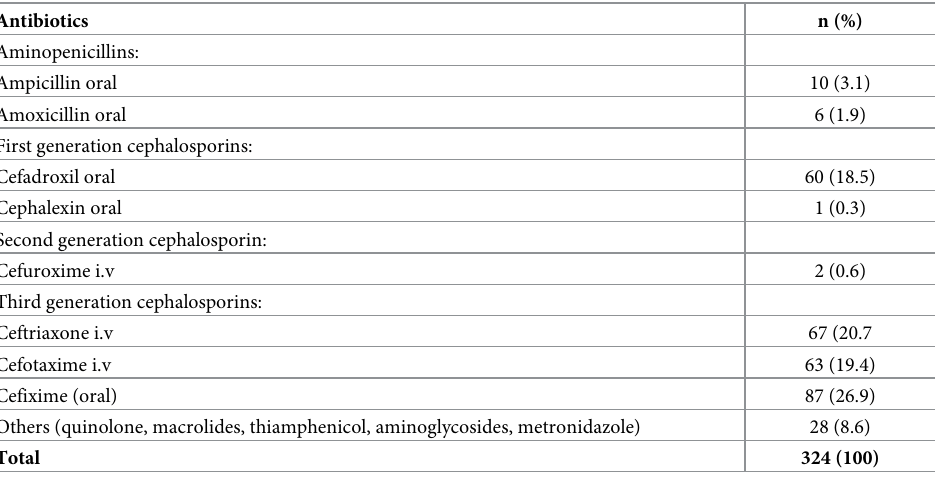
Table 4. Antibiotics used in DVI with concurrent presumed URTI in private hospitals.